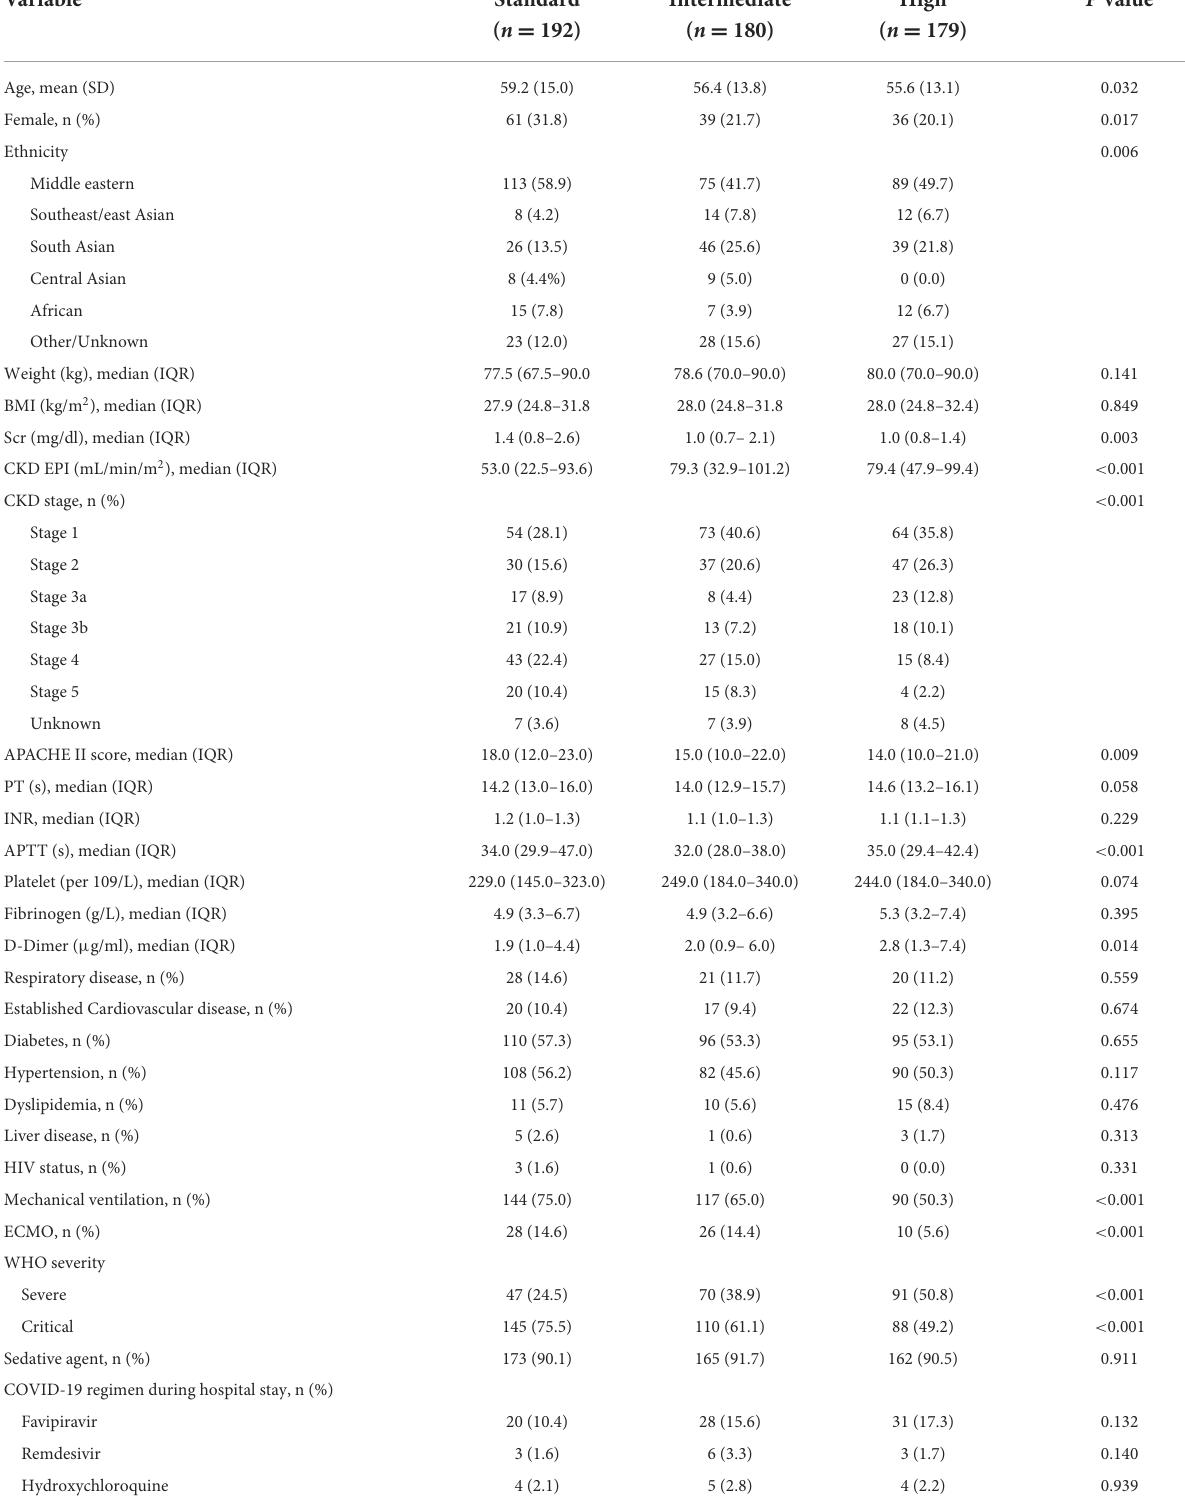
TABLE 1 Baseline